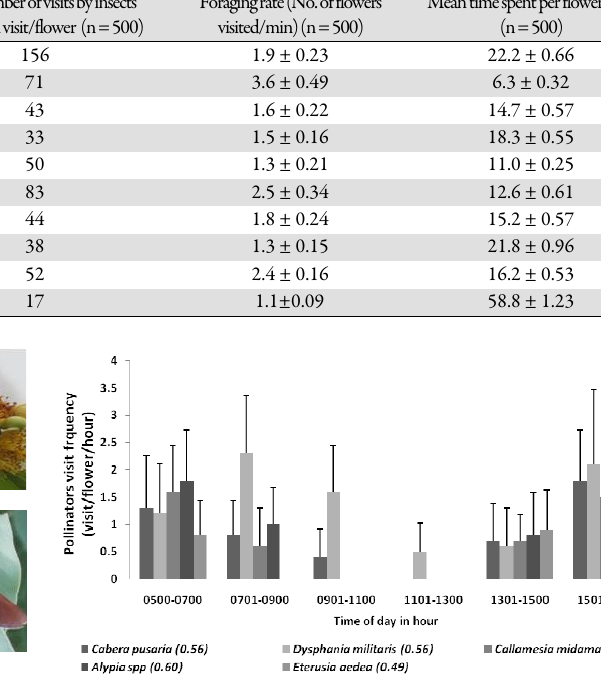
Table 2. Insects visiting the flowers of Schima wallichii in tropical forest site of Mizoram Order